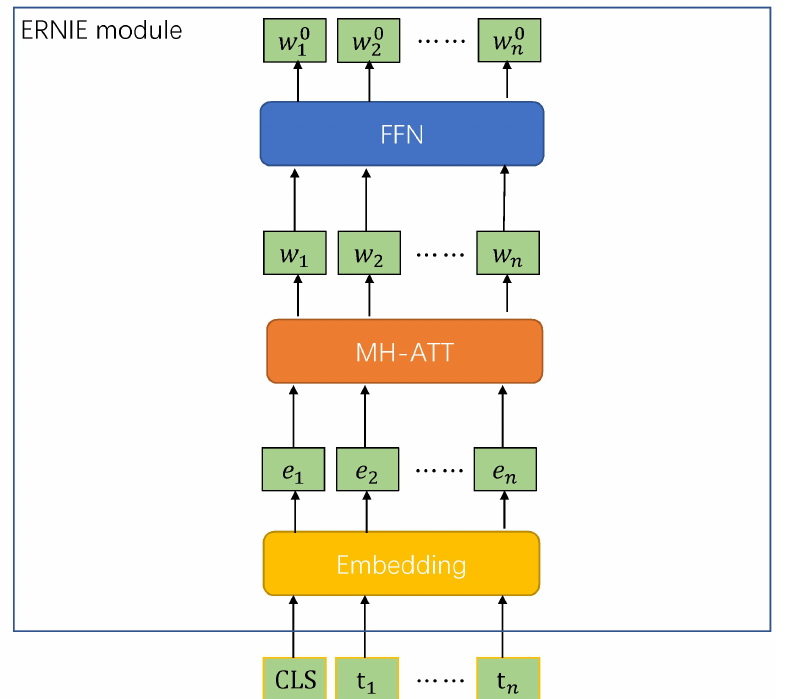
Figure 3. The operational flow of the ERNIE